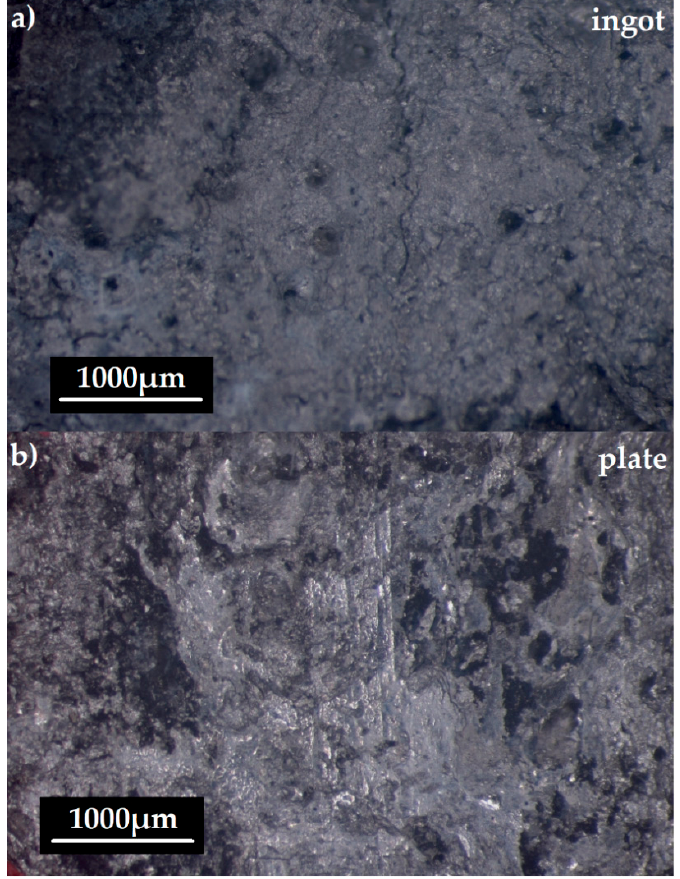
Figure 5 . Surface morphology after electrochemical tests of Mg 60 Zn 20 Ca 2.6 Yb 15.7 Sr 1.7 alloy in a form of ( a ) ingot and ( b )